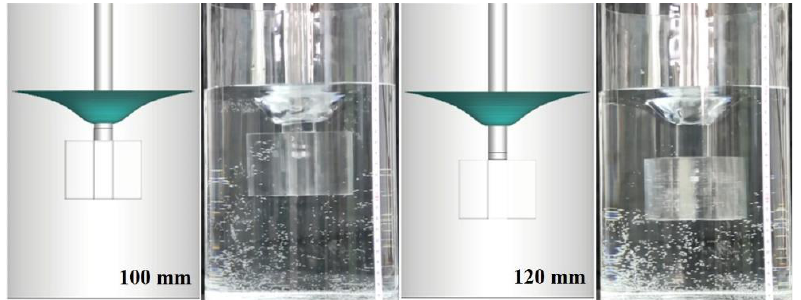
Figure 4. Comparison of vortex depth of numerical simulation and water model at impeller immer- sion depths of 100 mm and 120 mm.